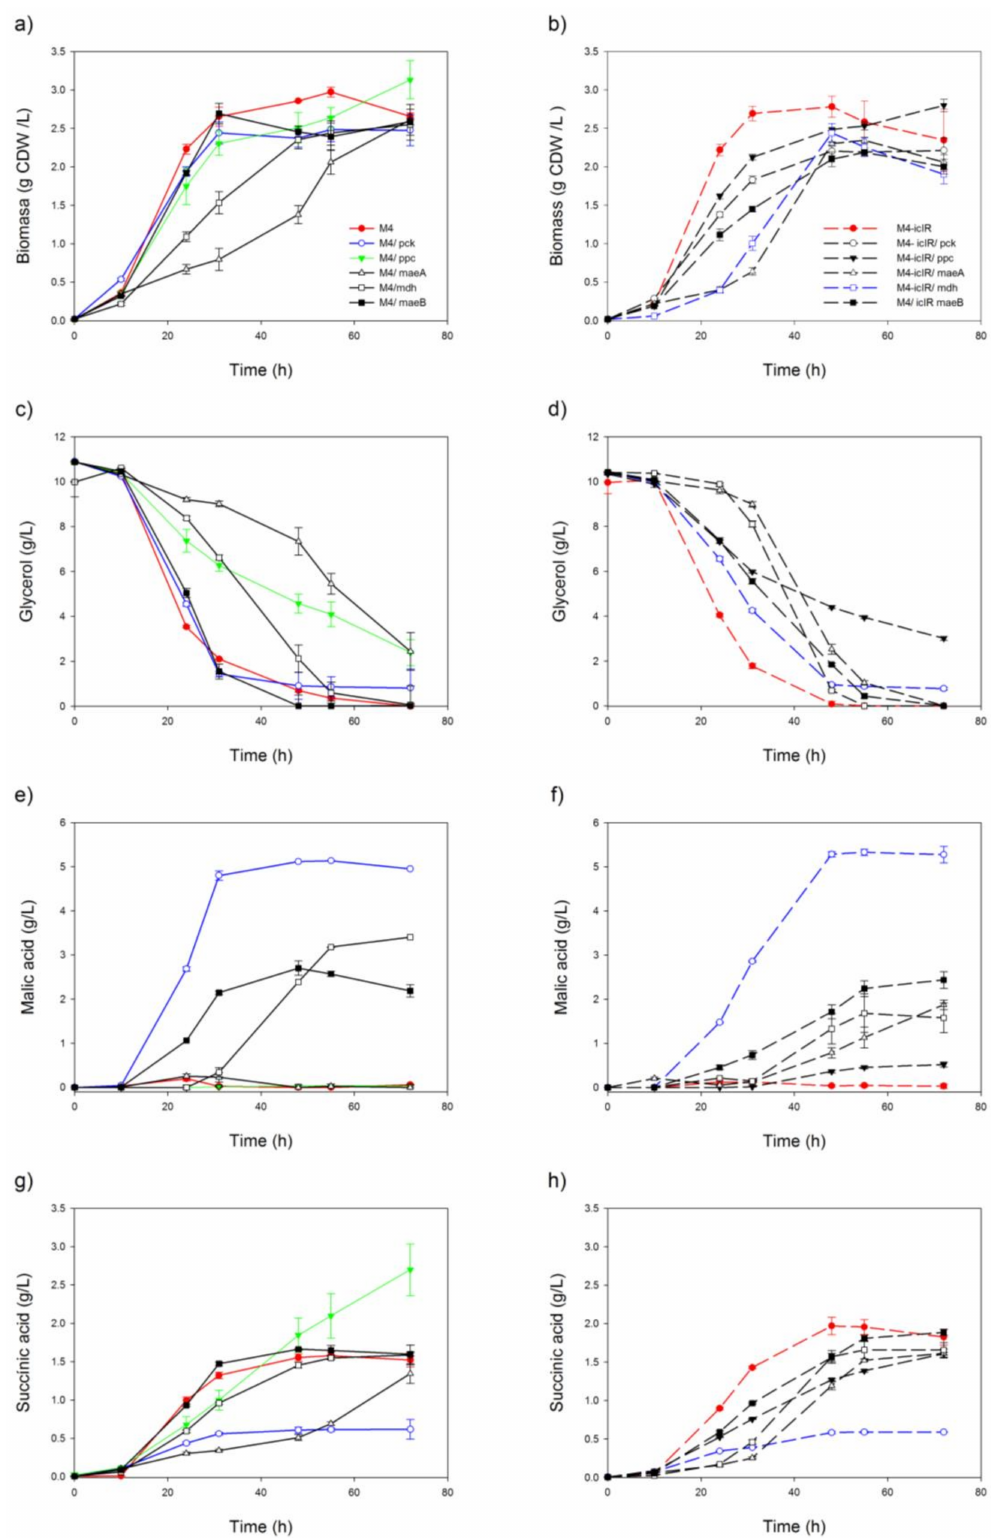
Figure 1. Curve plots of parameters measured in a screening of anaplerotic and cataplerotic overexpression on the engineered M4 ( a , c , e , g ) and M4- ∆ iclR strains ( b , d , f , h ). Biomass growth in cell dry weight (CDW)/L ( a , b ). Glycerol not consumed in g/L ( c , d ). Malic acid production in g/L ( e , f ) and succinic acid production in g/L ( g , h ). All these parameters were evaluated at 0, 10, 24, 31, 48, 55 and 72 h. The overexpression’s enzymes cloned in pBAD vectors were induced with 0.02%